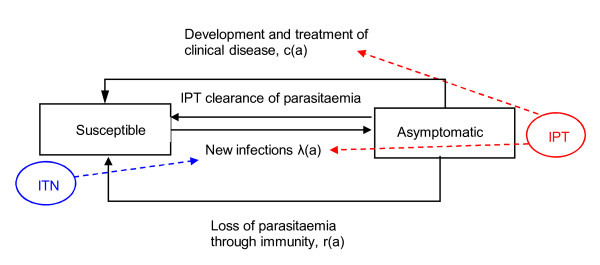
The asymptomatic parasite pool model.